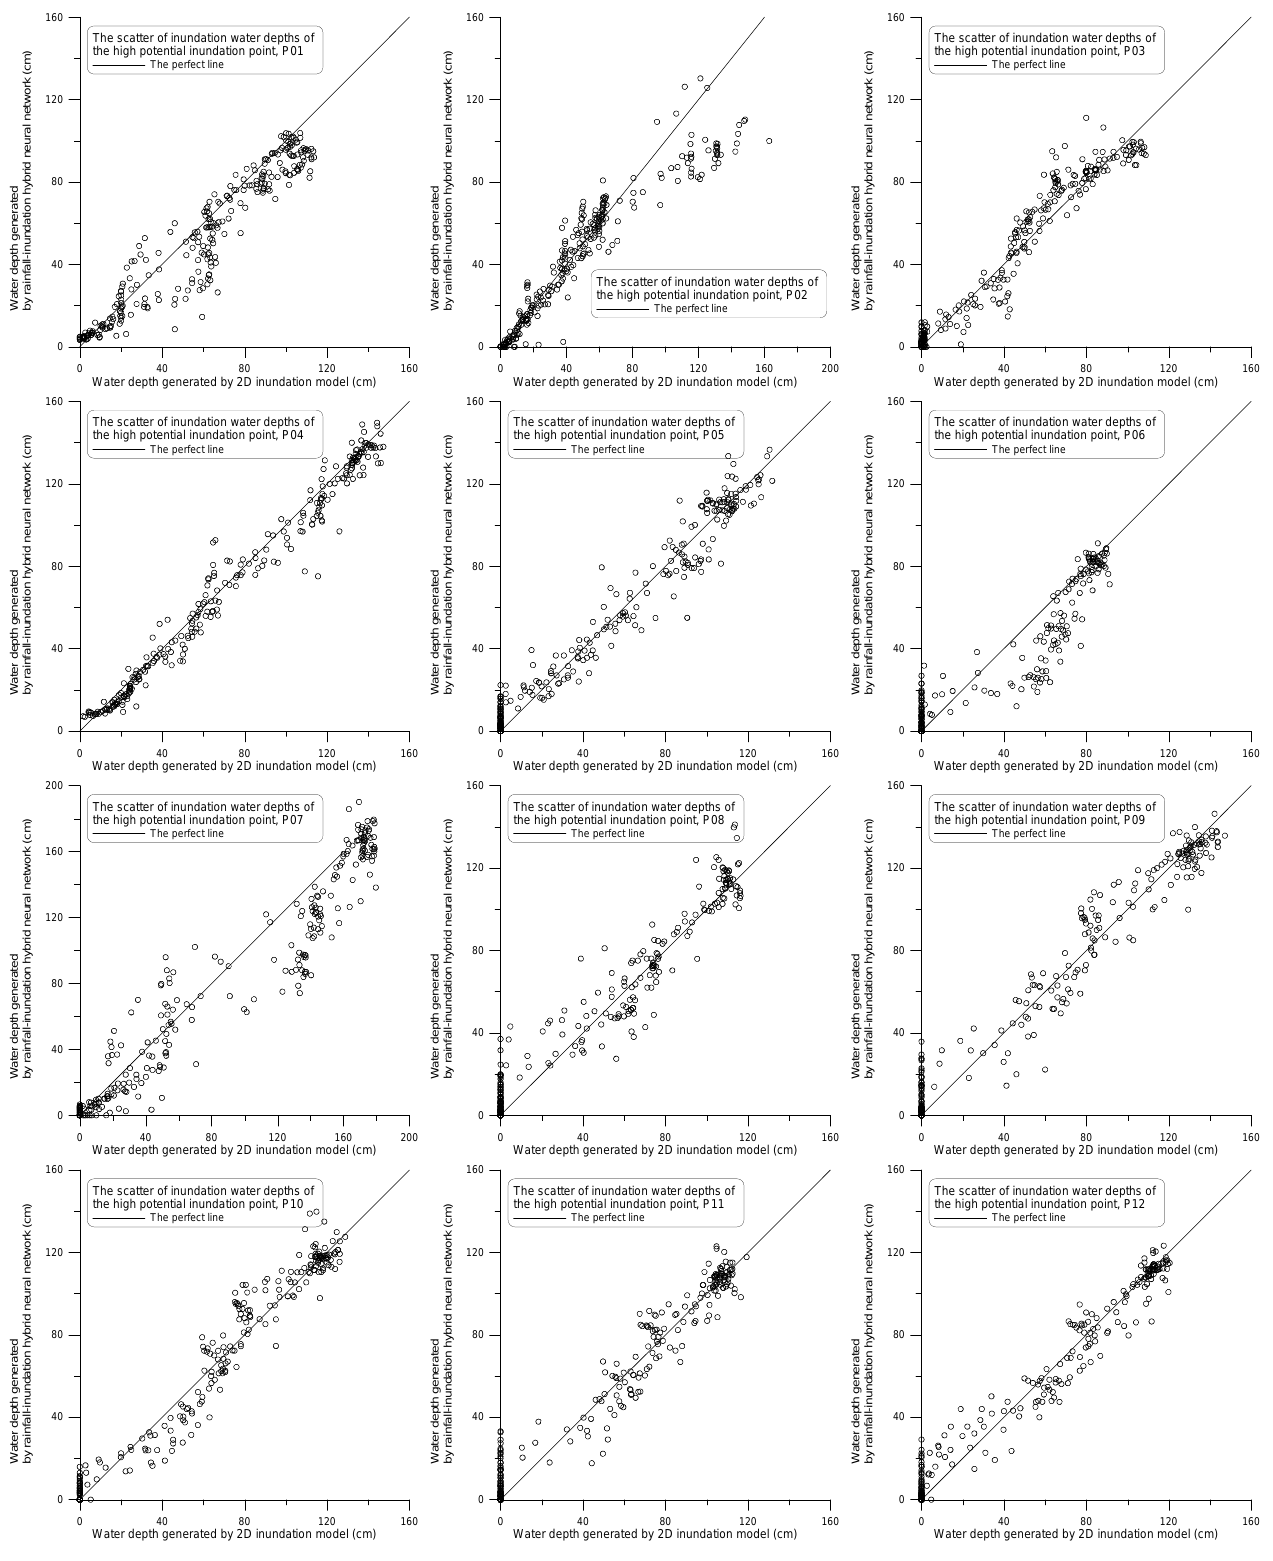
Fig. 8. The scatter plots of the forecast by RiHNN (Model D) and the synthetic inundation by 2-D overland-flow model for the P01 ∼ P12 representative inundation